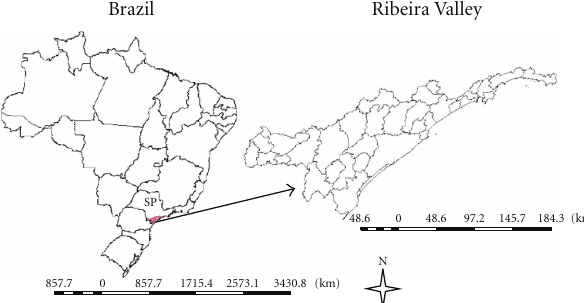
Figure 1: Location of the study area: Ribeira Valley and Coastal region of the State of S˜ao Paulo,